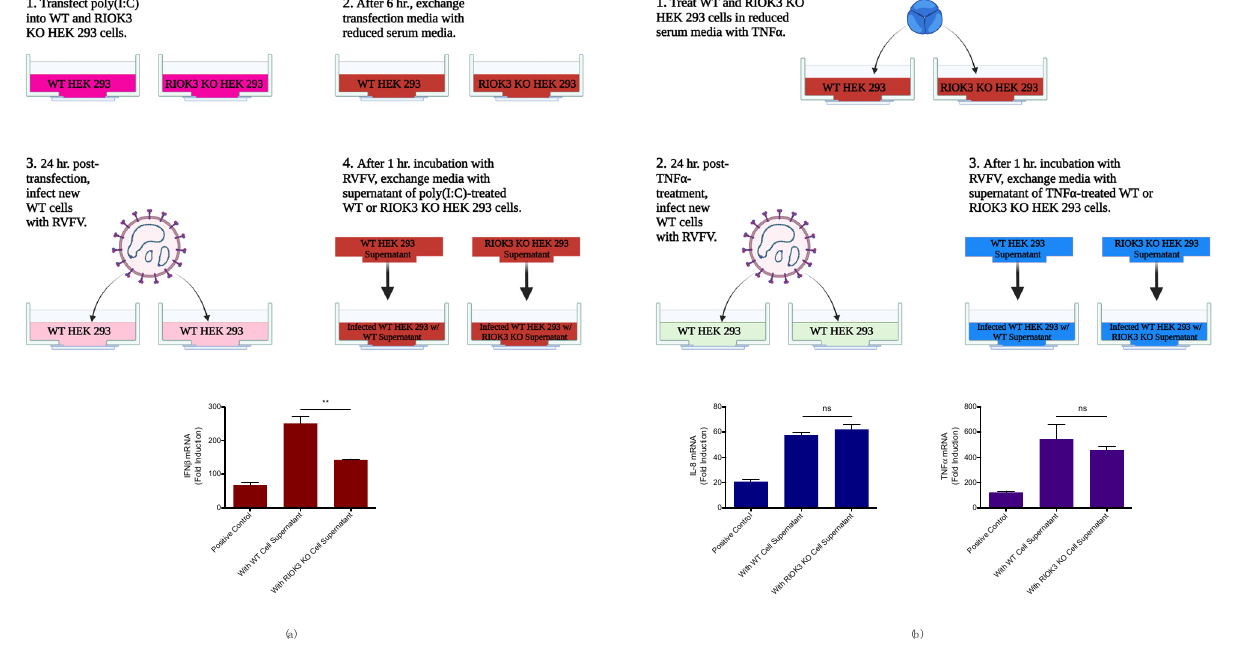
Figure 2. Paracrine communication from cells deficient in RIOK3 elicits diminished IFN response to infection with RVFV. ( a ) WT or RIOK3 KO cells were immune stimulated with poly(I:C) (1 µ g/mL), and media from these cells was transferred to identical plates of WT cells infected with RVFV (see diagram). IFN β mRNA expression in the infected cells was measured by RT-qPCR. Cells treated with media from the WT cells elicited a stronger IFN response to infection than cells treated with media from RIOK3 KO cells. ( b ) Similarly, WT or RIOK3 KO cells were treated with TNF α at a concentration of 20 ng/mL, and media from these cells was transferred to identical plates of WT cells infected with RVFV (see